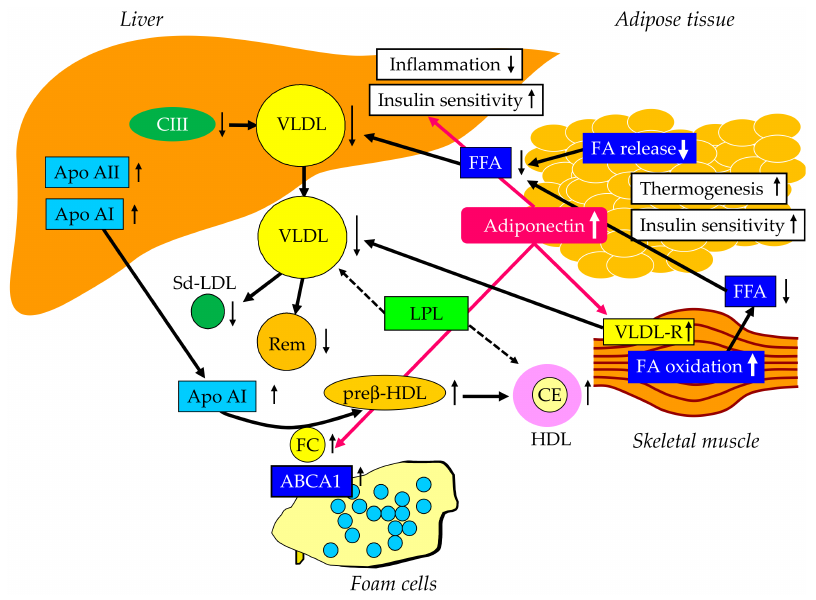
Figure 5. PPAR α agonist-induced improvements of lipid metabolism. ABCA1, ATP-binding cassette transporter A1; CE, cholesterol ester; FC, free cholesterol; FFA, free fatty acid; HDL, high-density lipoprotein; IDL, intermediate-density lipoprotein; LPL, lipoprotein lipase; Sd-LDL, small dense LDL; Rem, remnant; VLDL, very-low-density lipoprotein; VLDL-R, very-low-density lipoprotein